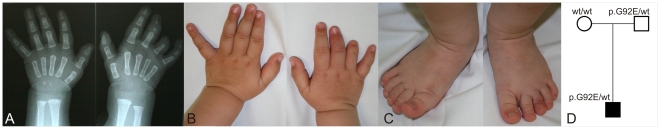
Patient phenotype.X-rays of the patients hands (A) were taken before the operation, at the age of 4 months, showing the unilateral atypical BDB-like phenotype. Photographs of hands (B) and feet (C) were taken after the surgical correction, at the age of 22 months. Note that the middle phalanx of the 3rd left toe was removed and implanted as the middle phalanx of the 3rd finger of the right hand in order to stabilize the digit and improve functionality. The pedigree (D) shows the patient carrying the heterozygous change p.G92E in NOG which he inherited from the healthy father.